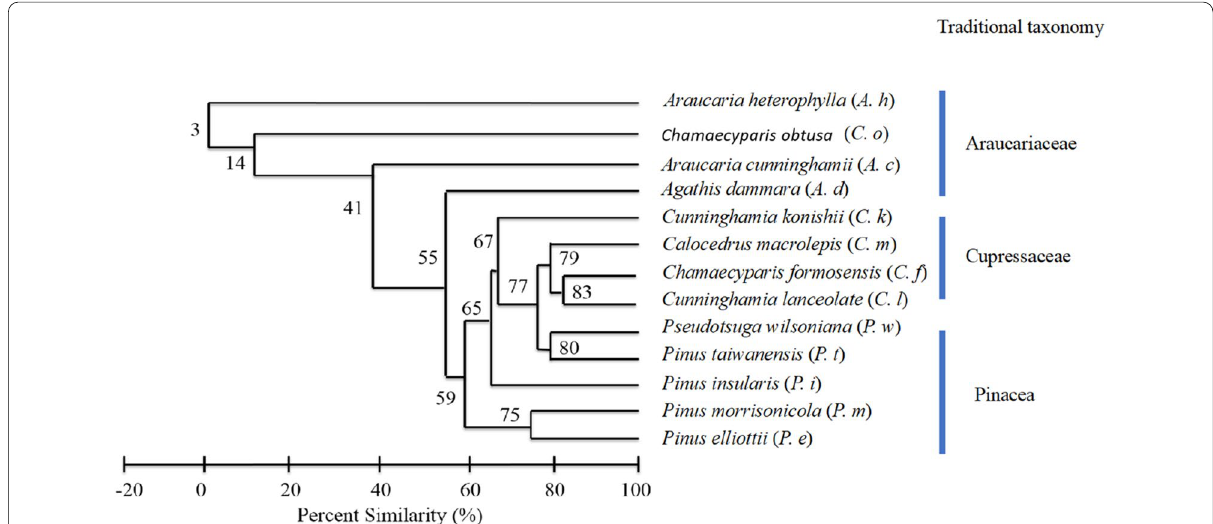
Fig. 2 Epigenetics of conifers relationship of 13 conifers grown in Taiwan by GC–MS analysis of volatile constituents from exudates